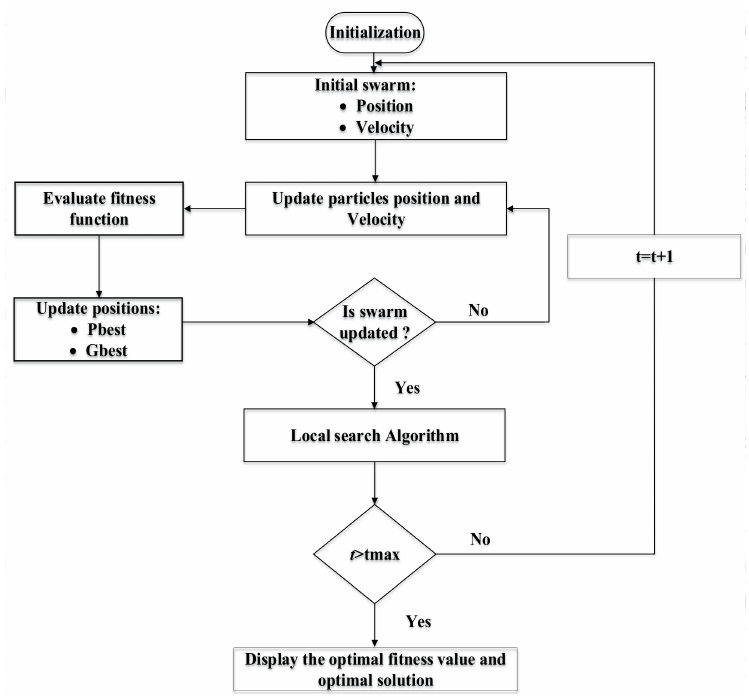
Figure 2. Flow chart of continuous particle swarm optimization (CPSO).